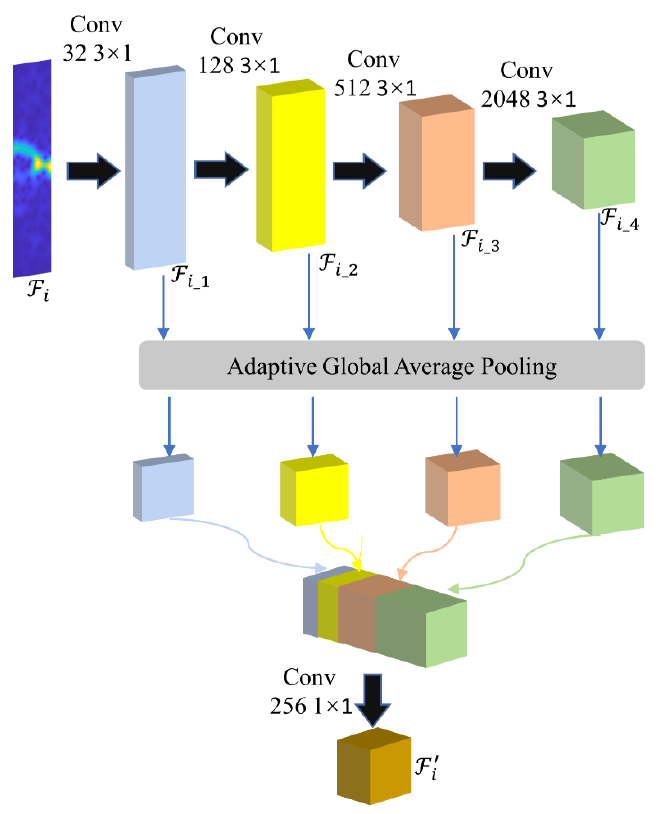
Figure 2. The structure of the 1D-MFF module.